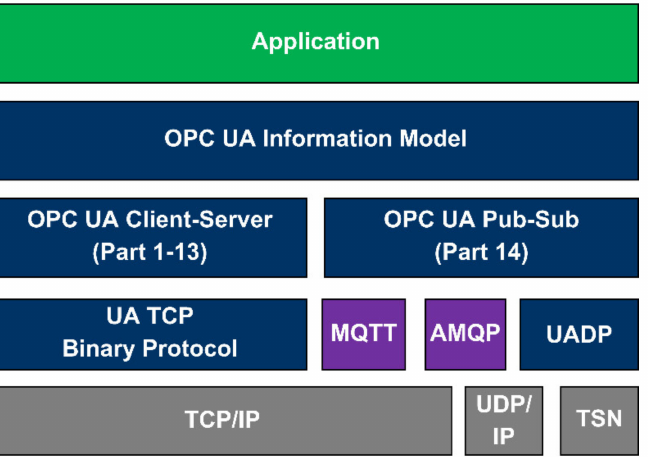
Figure 1. The open platform communications unified architecture (OPC UA) protocol stack. MQTT,